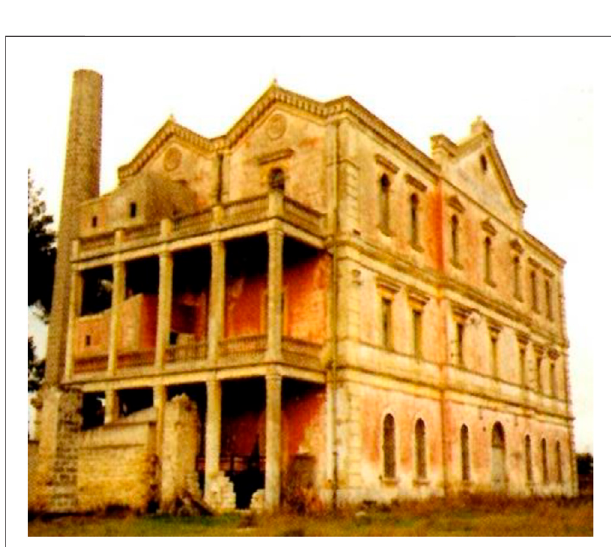
FIGURE 3 | Flour mill “ Alfredo Pagano ” located in southern Italy (Apulia